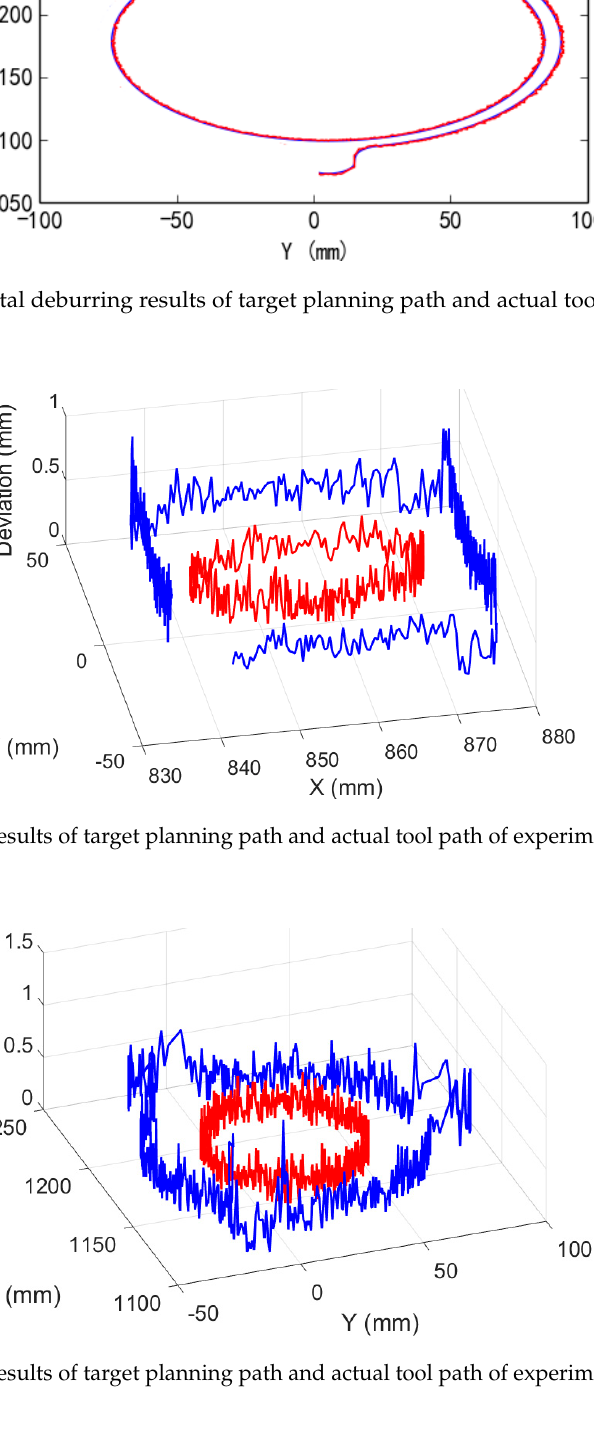
Figure 33. Deviation results of target planning path and actual tool path of experimental deburring for distal side facet.